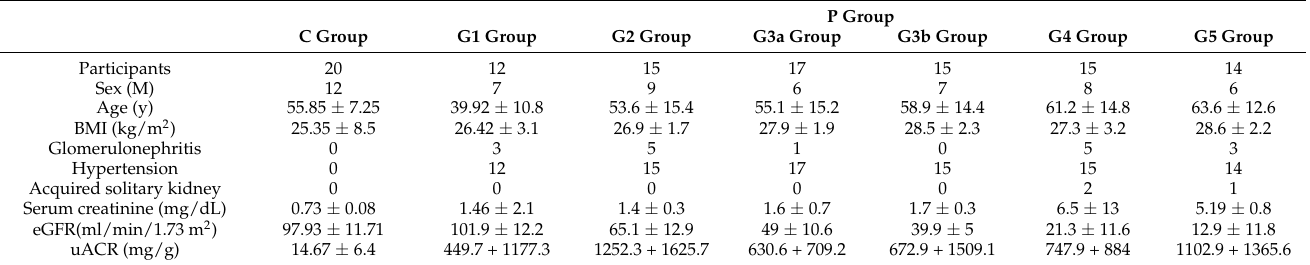
Table 1. Demographic, clinical, and biological data for group C and the CKD